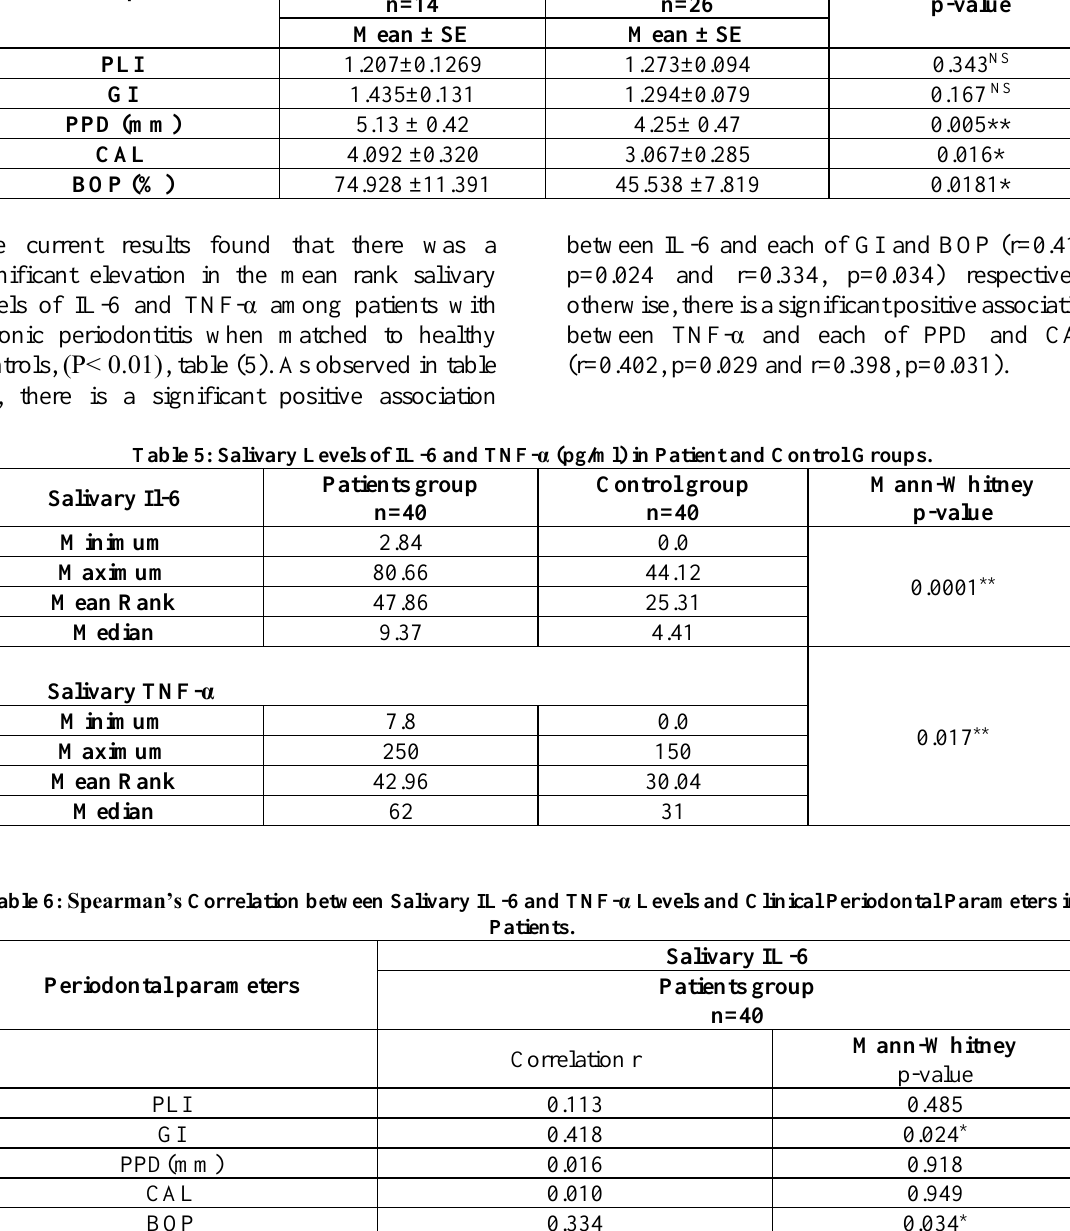
Table 4: Association between the Presence of Anti-CMV IgG Iu/ml and Clinical Periodontal Parameters. Periodontal parameters